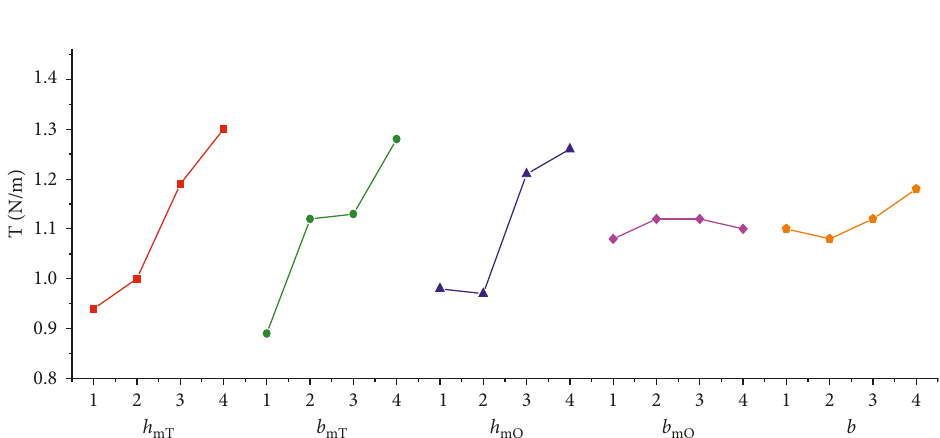
Figure 4: Impact of various factors on K